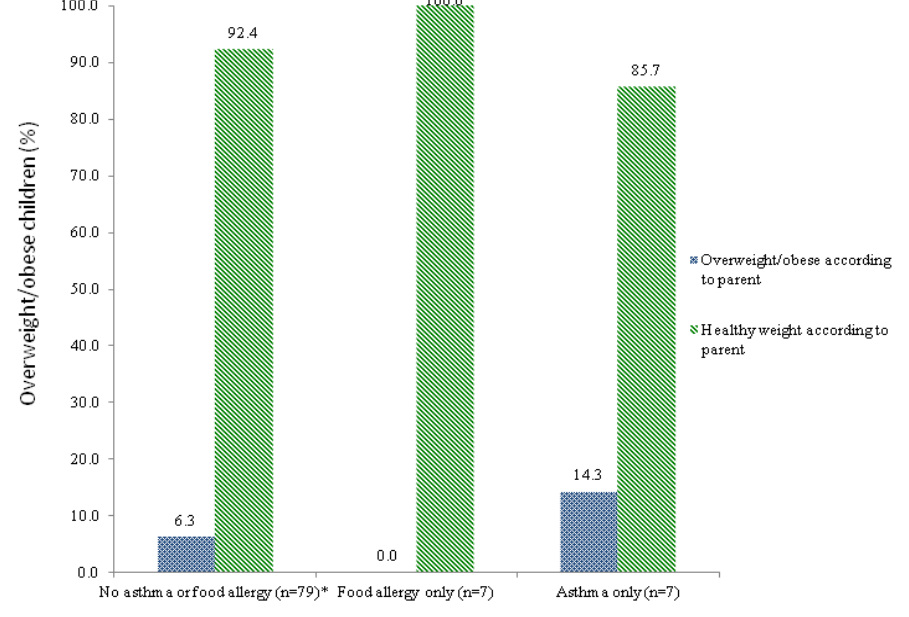
Figure 2. Child’s weight status (%) as perceived by the parent in children classified as overweight/obese according to BMI